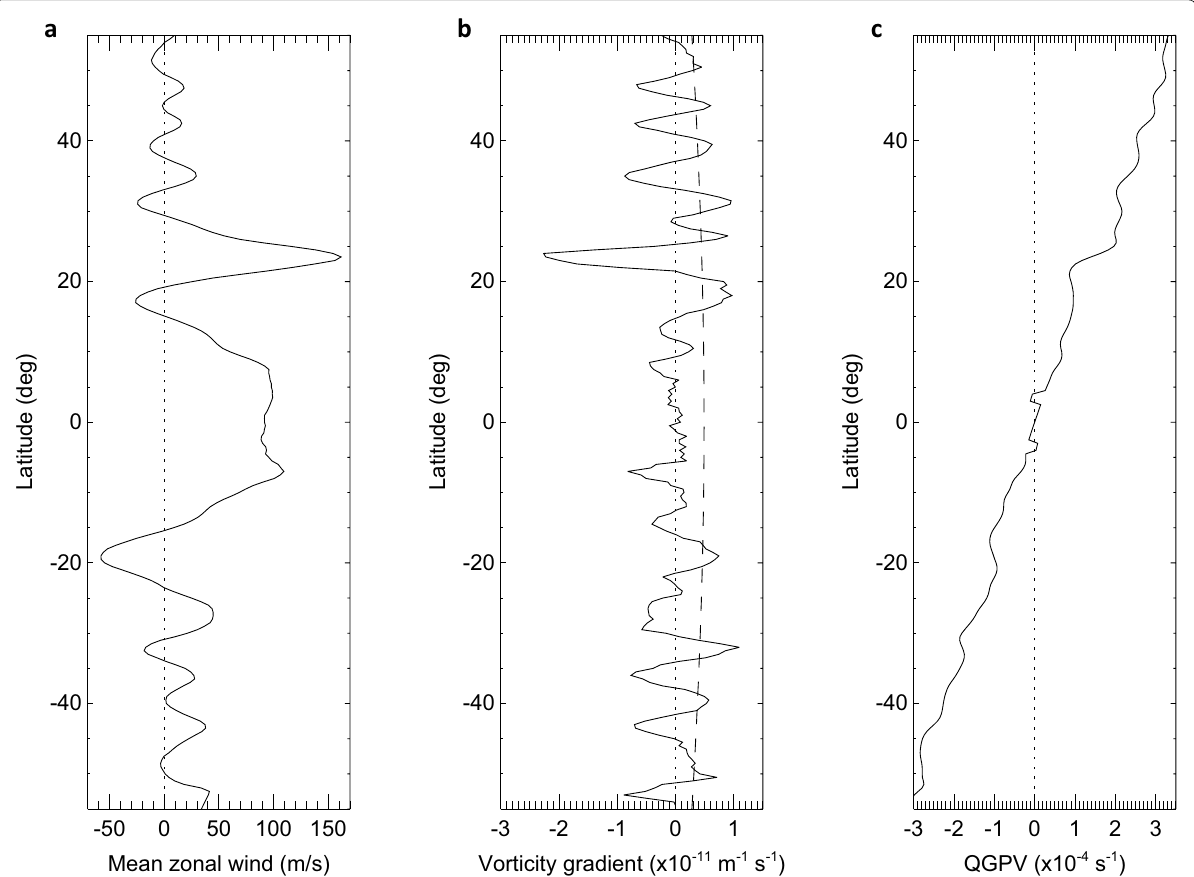
Fig. 3 Observed structure in a zonal velocity, b northward gradient of relative vorticity and c quasi-geostrophic potential vorticity of Jupiter’s cloud-level zonal jets, as derived by Read et al. (2006) from Cassini cloud tracking measurements (Porco et al. 2003) and infrared thermal retrievals from the Cassini Composite Infrared Spectrometer